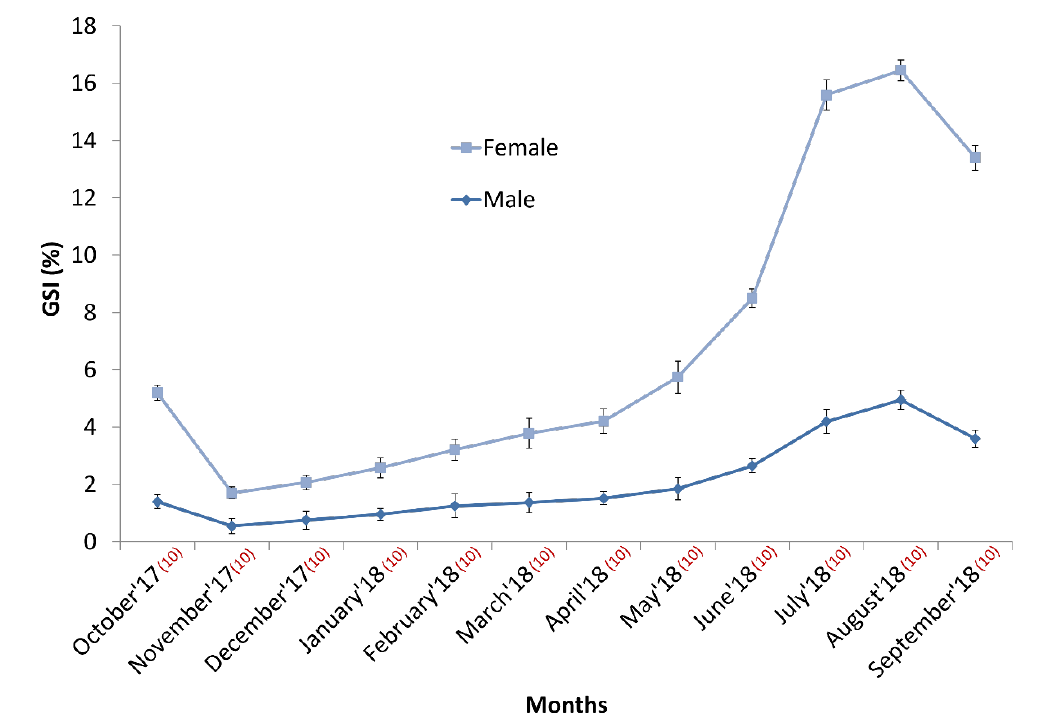
Figure 3. Year-round GIS variation between males and females during in-house domestication of Ariza labeo ( L. ariza ).